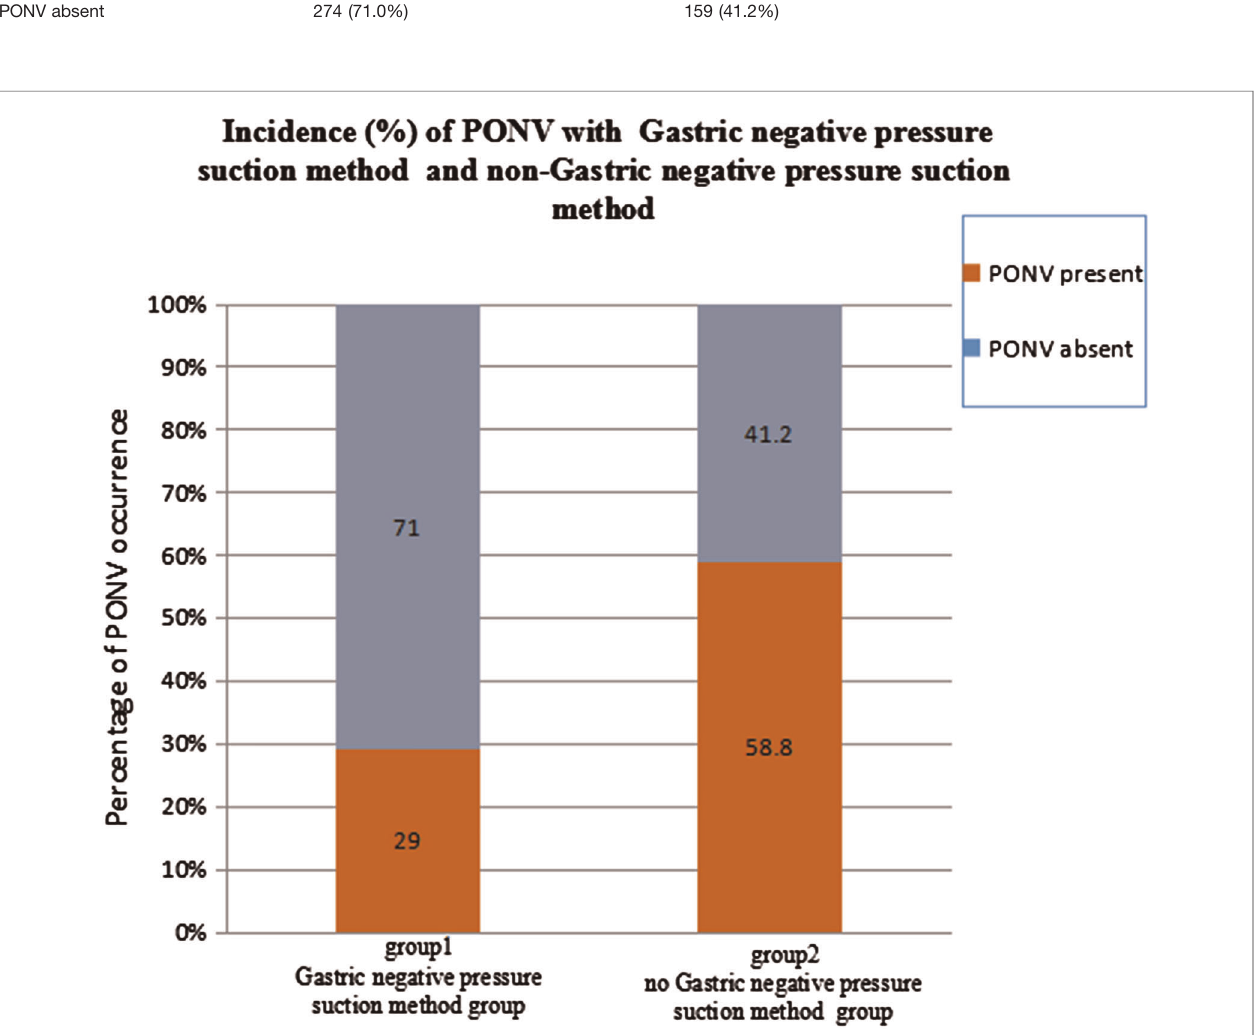
FIGURE 1 | The incidence of PONV in patients undergoing the Gastric negative pressure suction method after orthognathic general anaesthesia was 29.8% lower than that in patients without the Gastric negative pressure suction method.